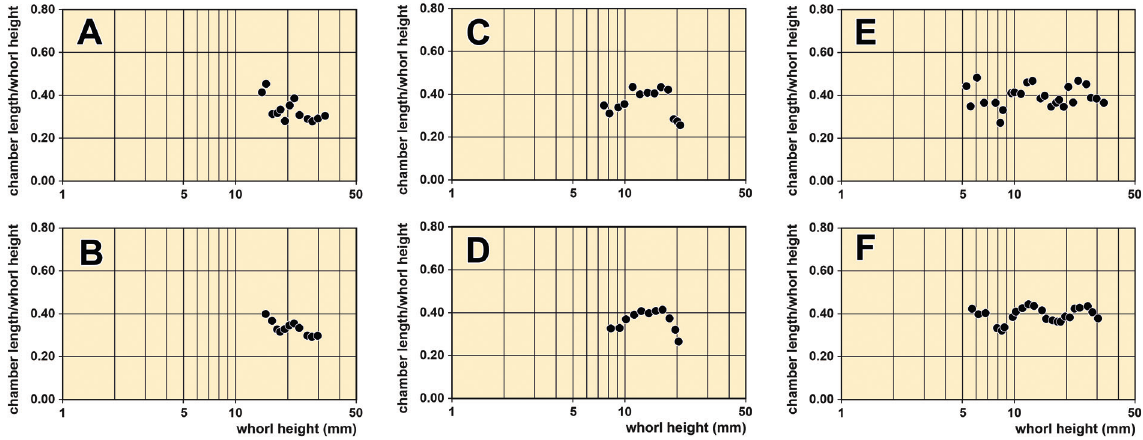
Fig. 11. Septum distances in Rhynchorthoceras angelini (Boll, 1857) from the Upper Red Orthoceratite Limestone. Upper row = empirical data points; lower row = three data points averaged. A–B . Specimen MB.C.11725.1 (Remelé 1879 Coll.) from Heegermühle (Brandenburg). C–D . Specimen MB.C.11716 (Hentig 1880 Coll.) from Joachimsthal (Brandenburg). E–F . Specimen MB.C.29653 (Bottke Coll.) from Gärdslösa (Island of Öland,